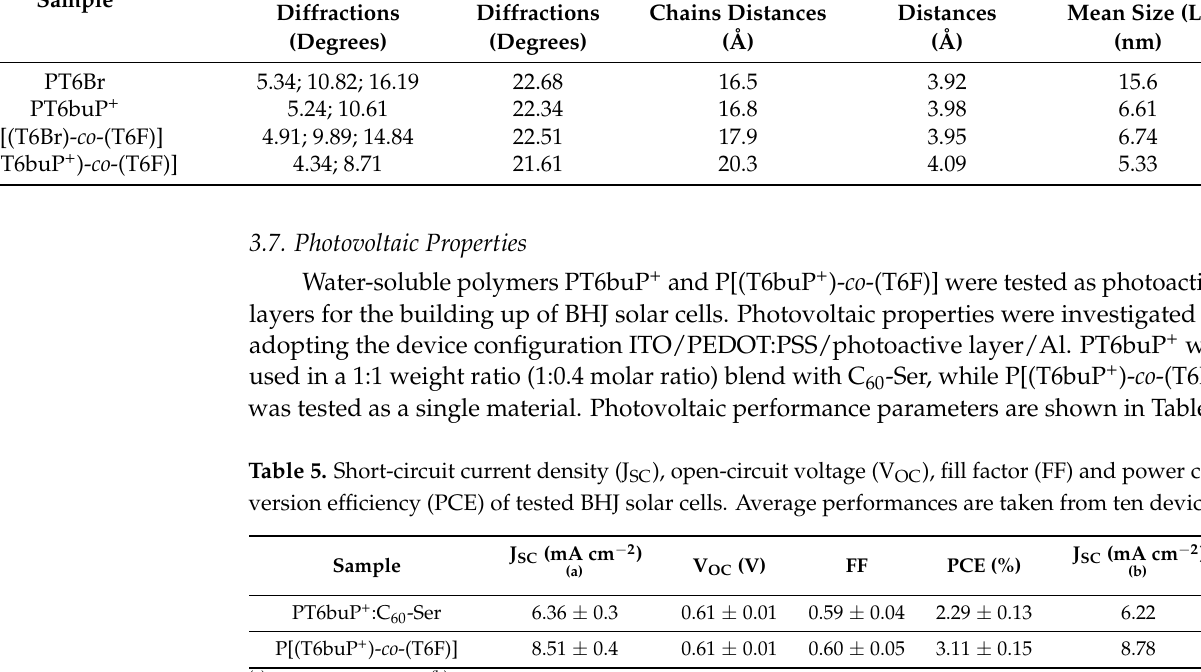
Table 4. Structural parameters of samples.